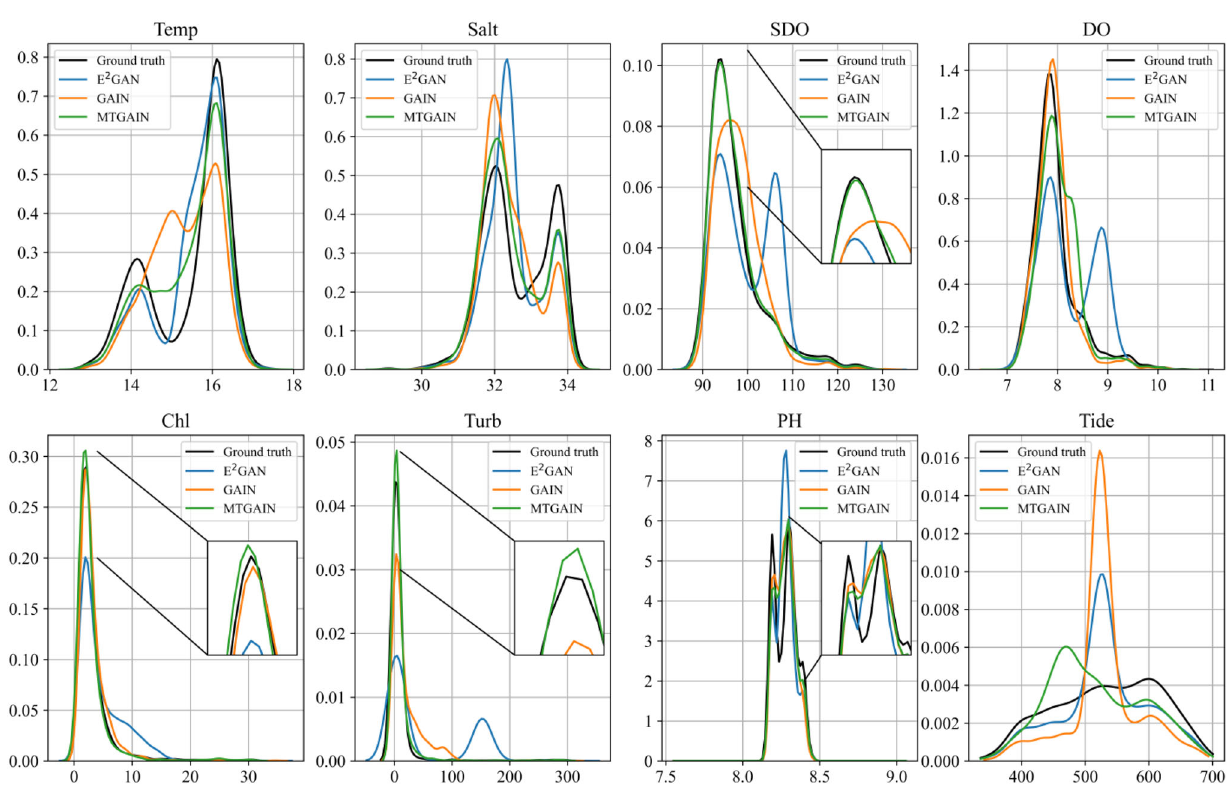
Fig. 3 The distributions of different attributions reconstructed by different methods under 50% missing